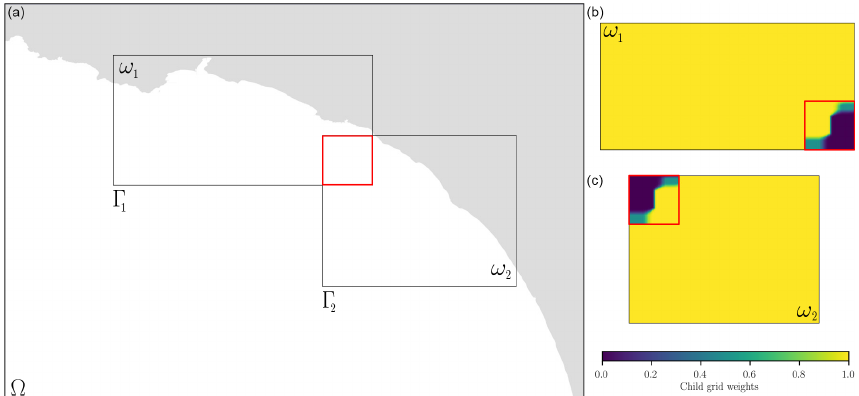
Figure 2. Diagram of the coupling between the barotropic and barotropic mode.